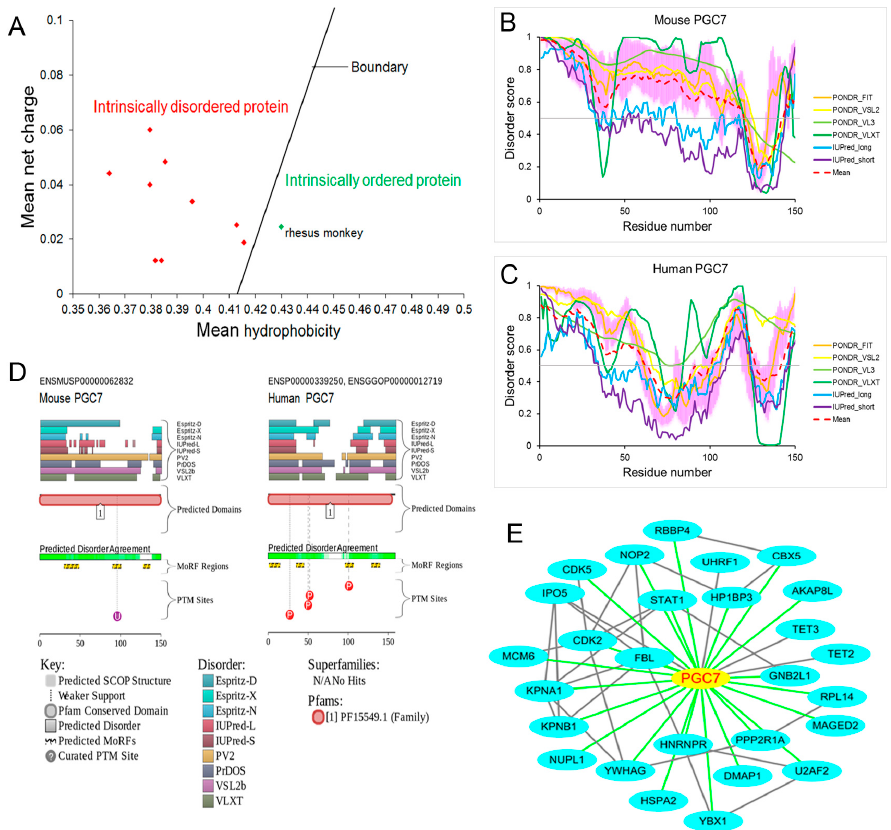
Figure 1. Evaluating functional intrinsic disorder and interactability of primordial germ cell 7 (PGC7). ( A ) Computational analysis (charge–hydrophobicity (CH) plot) of 10 mammalian PGC7 proteins. Intrinsically disordered and ordered proteins are separated by a linear boundary, which is described by the following relationship: Hb (mean hydrophobicity) = (R (mean net charge) + 1.151)/2.785. The mean hydrophobicity and mean net charge of PGC7 proteins were calculated with PONDR (http://www.pondr.com/). The green dot indicates the position of rhesus monkey PGC7 protein in the CH plot, the red dot indicates the position of another nine mammalian PGC7 proteins. ( B , C ) Evaluating intrinsic disorder propensity of mouse PGC7 (UniProt ID: Q8QZY3) and human PGC7 (UniProt ID: Q6W0C5) by series of per-residue disorder predictors. Disorder profiles generated by PONDR ® FIT, PONDR ® VSL2, PONDR ® VL3, PONDR ® VLXT, IUPred-long, and IUPred-short are shown by orange , yellow , light green , green , light blue and purple lines, respectively. Dark red dashed line shows the mean disorder propensity calculated by averaging disorder profiles of above six predictors. Light pink shadow around the PONDR ® FIT shows error distribution. The predicted disorder scores above the 0.5 threshold (the grey line) are considered as the disordered residues/regions. Detailed statistical information is listed in supplemental Table S1. ( D ) Intrinsic disorder propensity and disorder-related functional information generated for mouse and human PGC7 by the D 2 P 2 database. Here, the green-and-white bar in the middle of the plot shows the predicted disorder agreement between nine predictors. The green parts are disordered regions (75% of predictor ’s agree). Yellow bar shows the location of the predicted disorder-based binding sites (molecular recognition features, MoRFs). Coloured circles at the bottom of the plot show the location of various post-translational modifications (PTMs). ( E ) The interaction network of PGC7 with its partners. The network contains 28 nodes and 51 edges. Here, four proteins (IPO5, UHRF1, TET2 and TET3) are previously reported, 23 proteins are newly validated by our research team. The STRING online tool was used to determine the known interactions between PGC7 and its partners. We further visualized the network in Cytoscape and grafted our identified interactions onto it. The grey edges show the interaction obtained from the STRING database, whereas green edges show the interaction discovered by our research term.